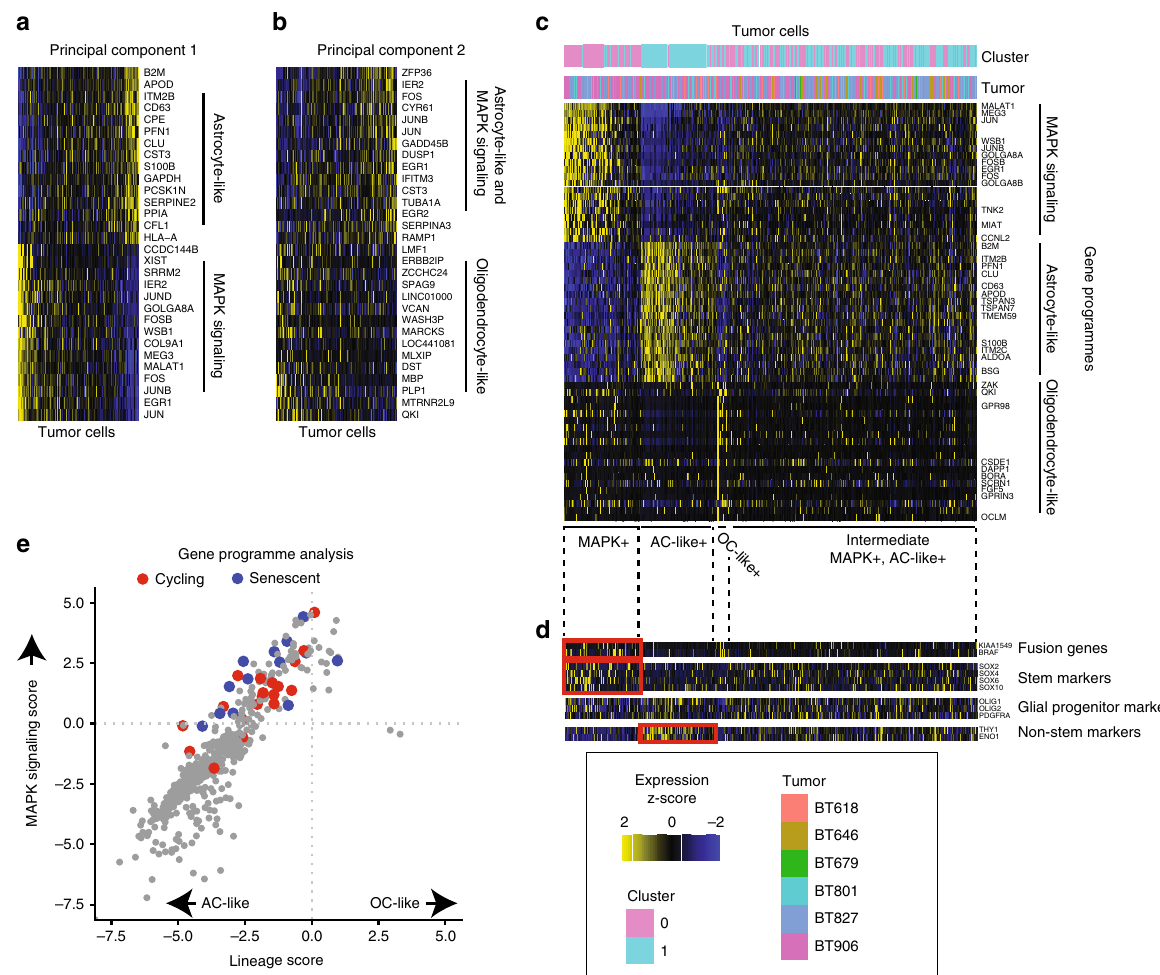
Fig. 5 MAPK signaling and glia-like gene programme in distinct subsets of PA cells. a Cancer cells ( n = 531, columns) ranked by principal component 1 derived from PCA of cancer cells. Rows indicate the 15 top and 15 bottom genes associated with principal component 1. b Cancer cells (columns) ranked by principal component 2; rows indicate genes associated with principal component 2. c Heat map showing expression of top 20 genes (rows) from MAPK signaling, astrocyte-like, and oligodendrocyte-like gene programme, across cancer cells (columns) ranked by their expression of each programme. d Expression of selected tumor markers in PA cancer cells from panel c. Red boxes mark populations with >2-fold increased mean scaled expression ( P < 0.0001 non-parametric Wilcoxon rank sum test) of the indicated genes compared to all other cells in the dataset. e Relative expression of MAPK signaling and oligodendrocyte-like (OC-like) or astrocyte-like (AC-like) programme in all PA cancer cells. Cells expressing a cell cycling programme are shown in red. Cells expressing a senescence signature are in